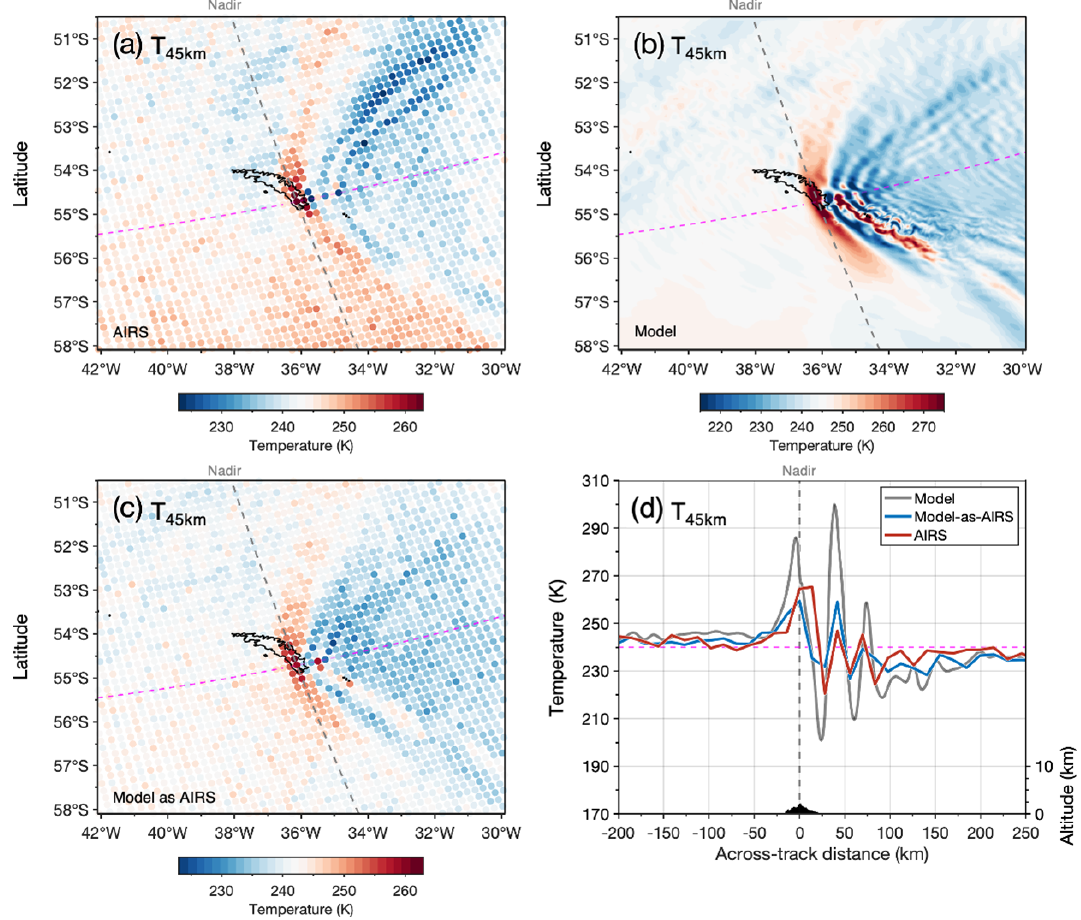
Figure 11. Temperature measurements over South Georgia at 45km altitude at 17:00UTC on 5 July 2015 for (a) AIRS satellite observations, the (b) full-resolution model and (c) the model sampled as AIRS. Coloured circles in (a) and (c) show the locations of the AIRS measurement footprints, while dashed grey lines show the satellite nadir, which passes directly over the island in this example. Panel (d) shows measured temperature at 45km altitude against horizontal across-track distance along the dashed pink line in (a–c) . Surface elevation along this path (right axes) is shown in black at the bottom of (d)